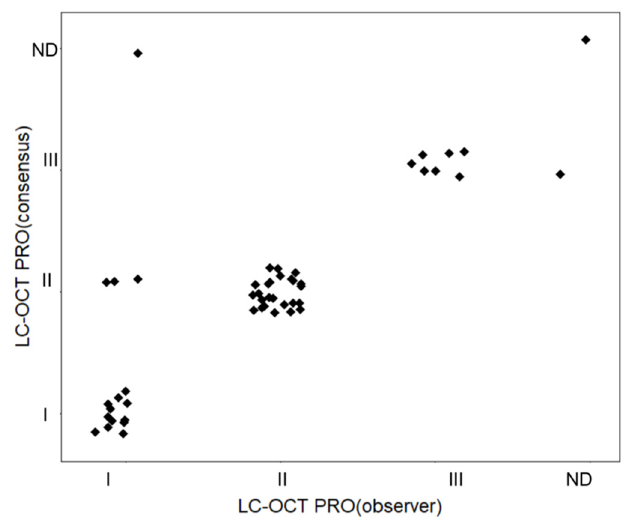
Figure 4. Interobserver agreement in the LC-OCT PRO classification of AKs. ND: not definable.